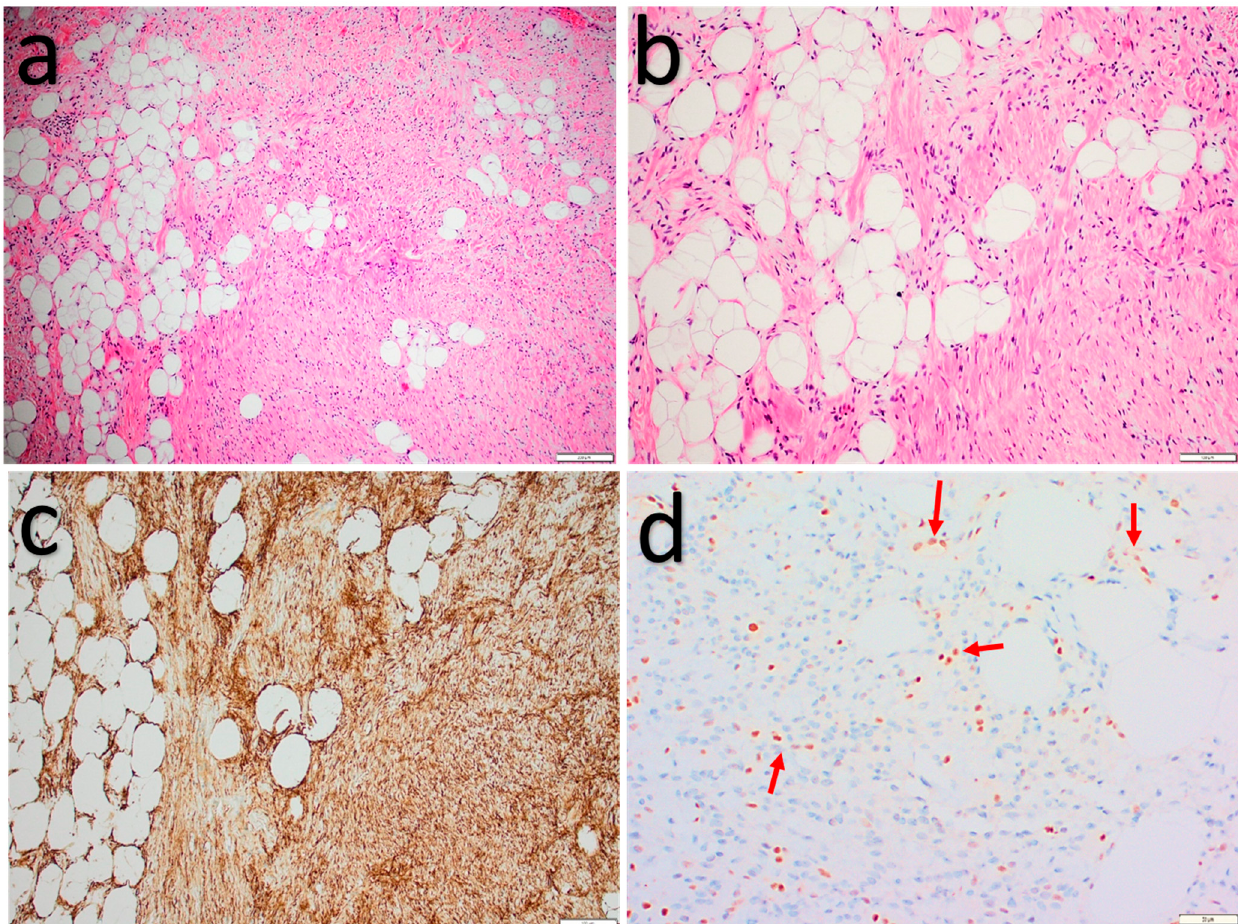
Figure 2. Spindle cell lipoma. ( a , b ) Bland spindle cells set in a fibromyxoid stroma mixed with mature adipocytes. ( c ) Strong, diffuse, cytoplasmatic CD34 expression. ( d ) Loss of nuclear Rb expression in the spindle cells and intact nuclear Rb expression in the endothelial cells (red arrows).